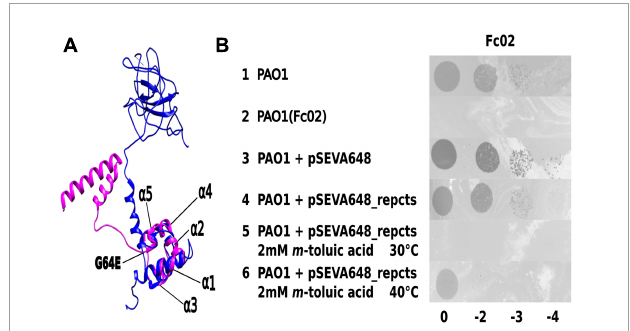
FIGURE1 Identification of phage Fc02 immunity repressor gene rep c and thermolability of repc ts mutant. (A) Model of the structural homology of phage lambda CI repressor X-ray crystal resolved structure (Stayrook et al., 2008) (blue) and the I-Tasser-predicted 3D structure of Fc02 ORF12 putative protein RepC (magenta). Notice the N-terminal domains overlapping of the proteins. The repc ts mutation G64E was located just beyond the last carboxy-side α -helix of the HTH motif of the putative protein. (B) Drop dilutions lysis pattern of phage Fc02 on the indicated strains and temperatures. The phage stock decimal dilutions used in each column are indicated at the bottom of the panel. Notice that Fc02 infects the uninduced transformant (row 4), as it does to wild type strain (row 1), but is unable to infect the m- toluic induced transformant at 30 ◦ C (row 5) and the PAO1(Fc02) lysogen (row 2).